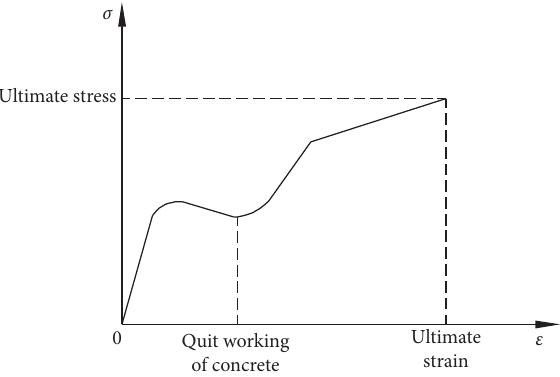
Figure 6: Tensile constitutive relation of unbonded region.